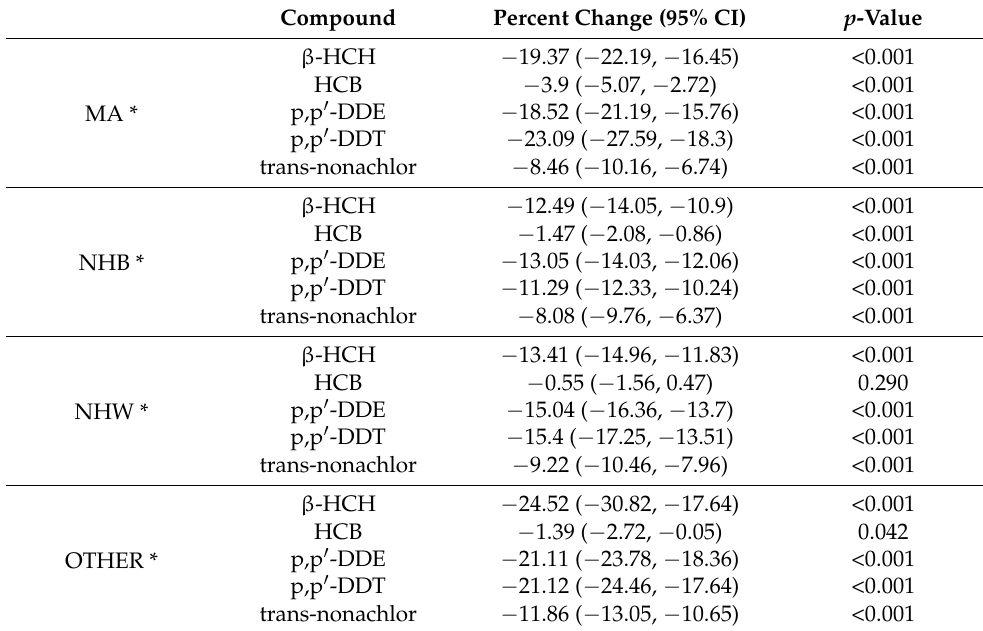
Table 6. Percent Change in Organochlorine Pesticides by the 2-Year Survey Cycle over